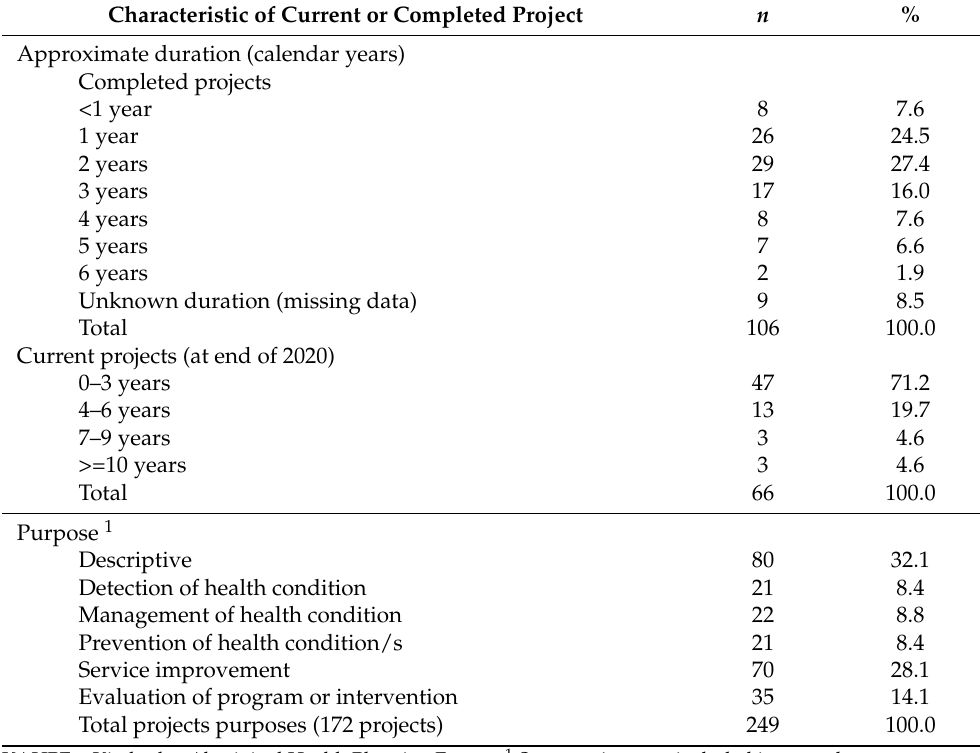
Table 2. Characteristics of completed and current projects with KAHPF Research